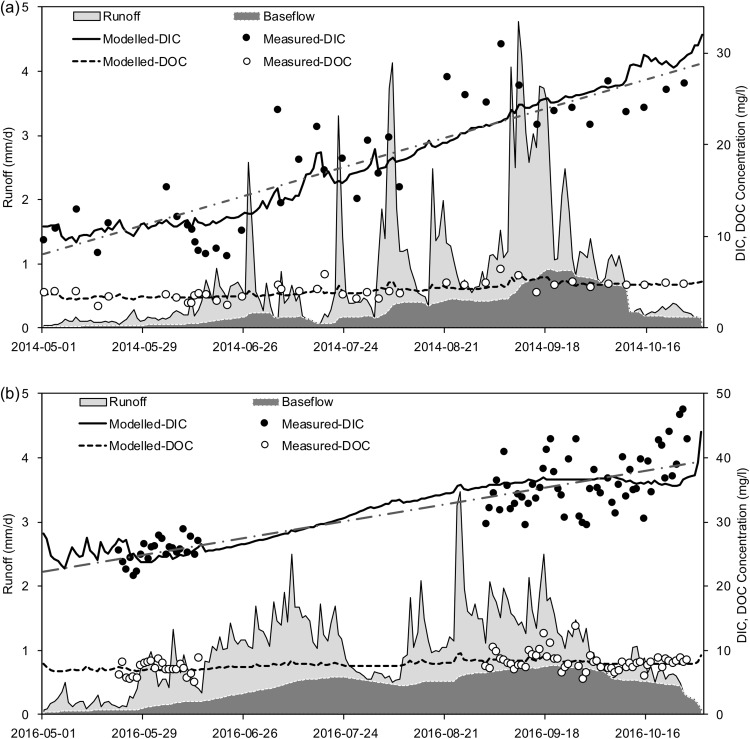
Runoff processes and time series of the riverine exported DIC and DOC concentrations at the outlet of Zuomaokong watershed (Catchment 1) during 2014 (A) and 2016 (B) freeze-free periods (May–October).The round solid and circle points are directly observed data and the solid lines are calculated from LOADEST model results. Daily discharge and baseflow are displayed with gray shades. The dashed straight lines are linear trends of measured DIC concentrations, while no significant trends were found for DOC concentrations. Note the linear trend lines based on measured DIC: (A), y = 0.11x—5.71, R2 = 0.72; (B), y = 0.09x + 10.76, R2 = 0.71; y represents DIC concentrations, x represents the day of the year.